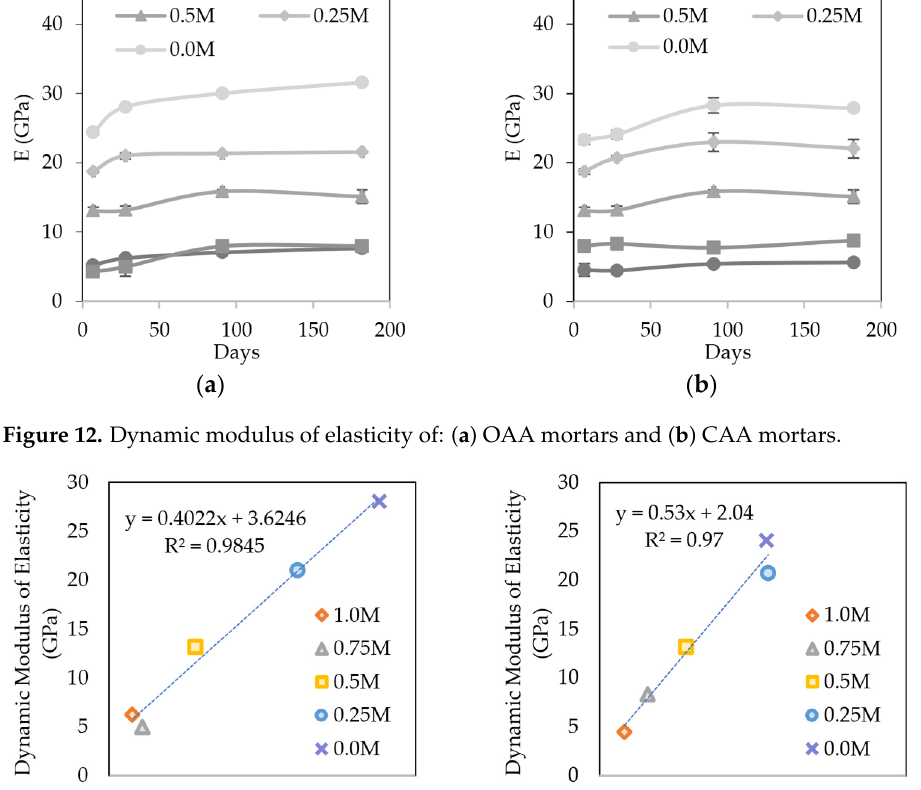
Figure 12. Dynamic modulus of elasticity of: ( a ) OAA mortars and ( b ) CAA mortars.